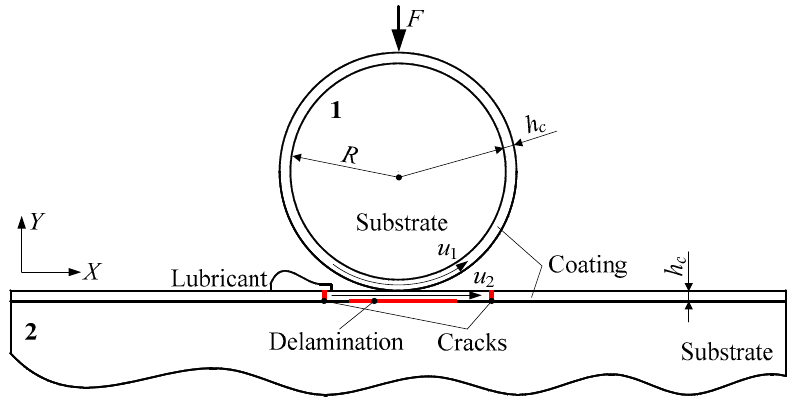
Figure 2. Schematic diagram of the elastohydrodynamic lubrication (EHL) model for coated surfaces in a line contact.